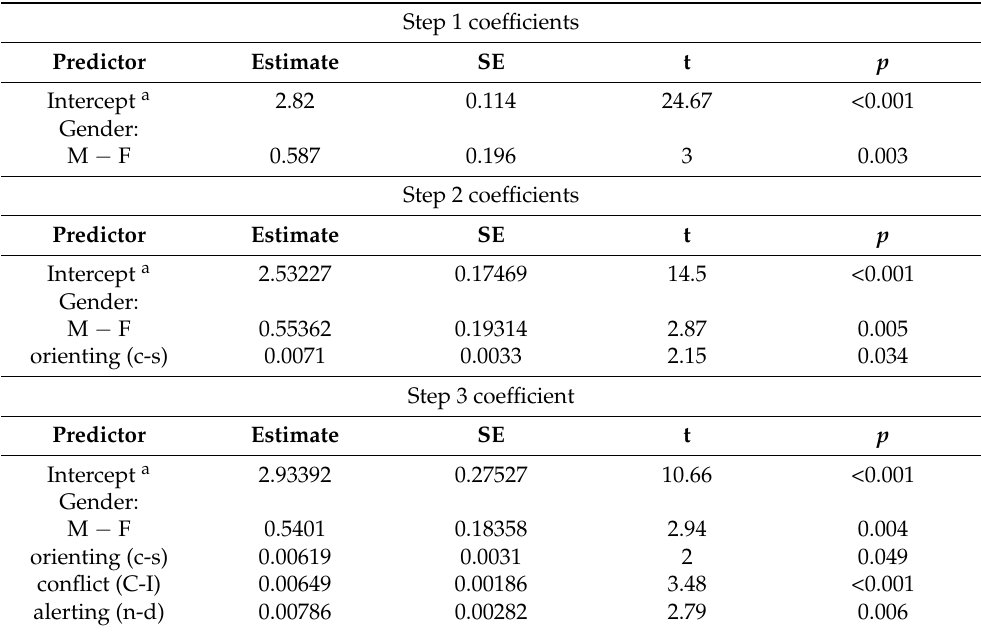
Table 3. Hierarhical regression analysis on gender and attentional network scores predicting d’ prime in the VR Goalkeeper